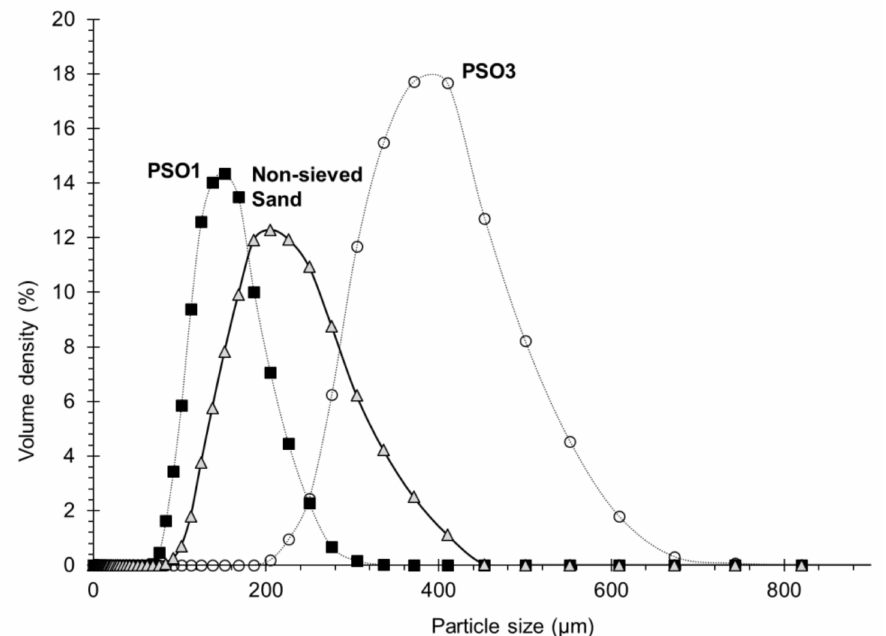
Figure 1. Experimental particle size distribution of calibrated Fontainebleau sand by di ff ractometer analysis: ( ∆ ) non-sieved sand; ( (cid:4) ) class PS01 particle; ( • ) class PS03 particle. Lines are used only to guide the